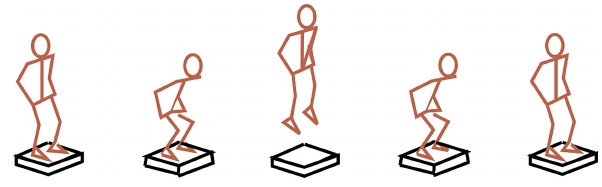
Fig. 2. Diagram of countermovement